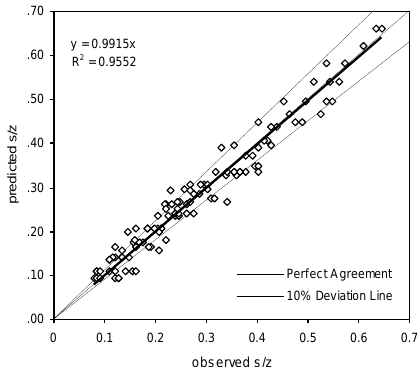
Figure 24. Comparison between observed and predicted equation (17) to estimate s/z . y = 0.9926x R 2 = 0.9364